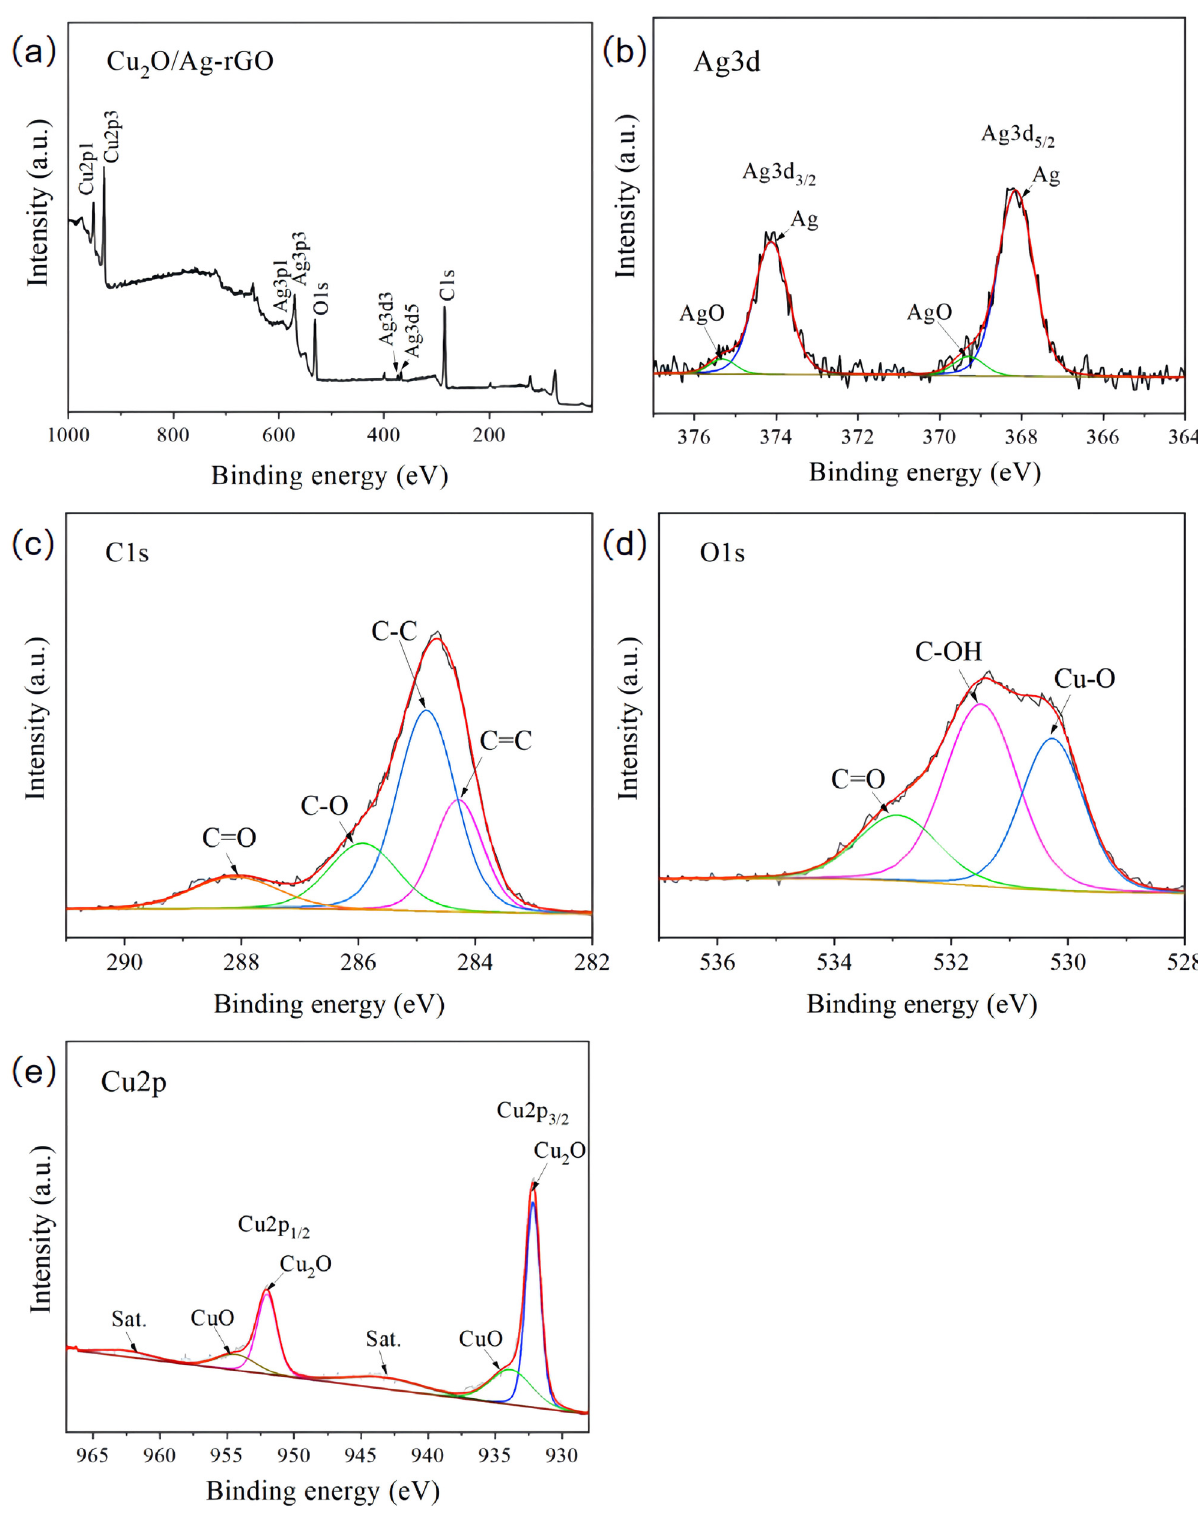
Figure 3: ( a ) XPS full spectrum of Cu 2 O/Ag - rGO nanocomposites. High - resolution XPS spectra of ( b ) Ag 3d, ( c ) C 1s, ( d ) O 1s, and ( e ) Cu